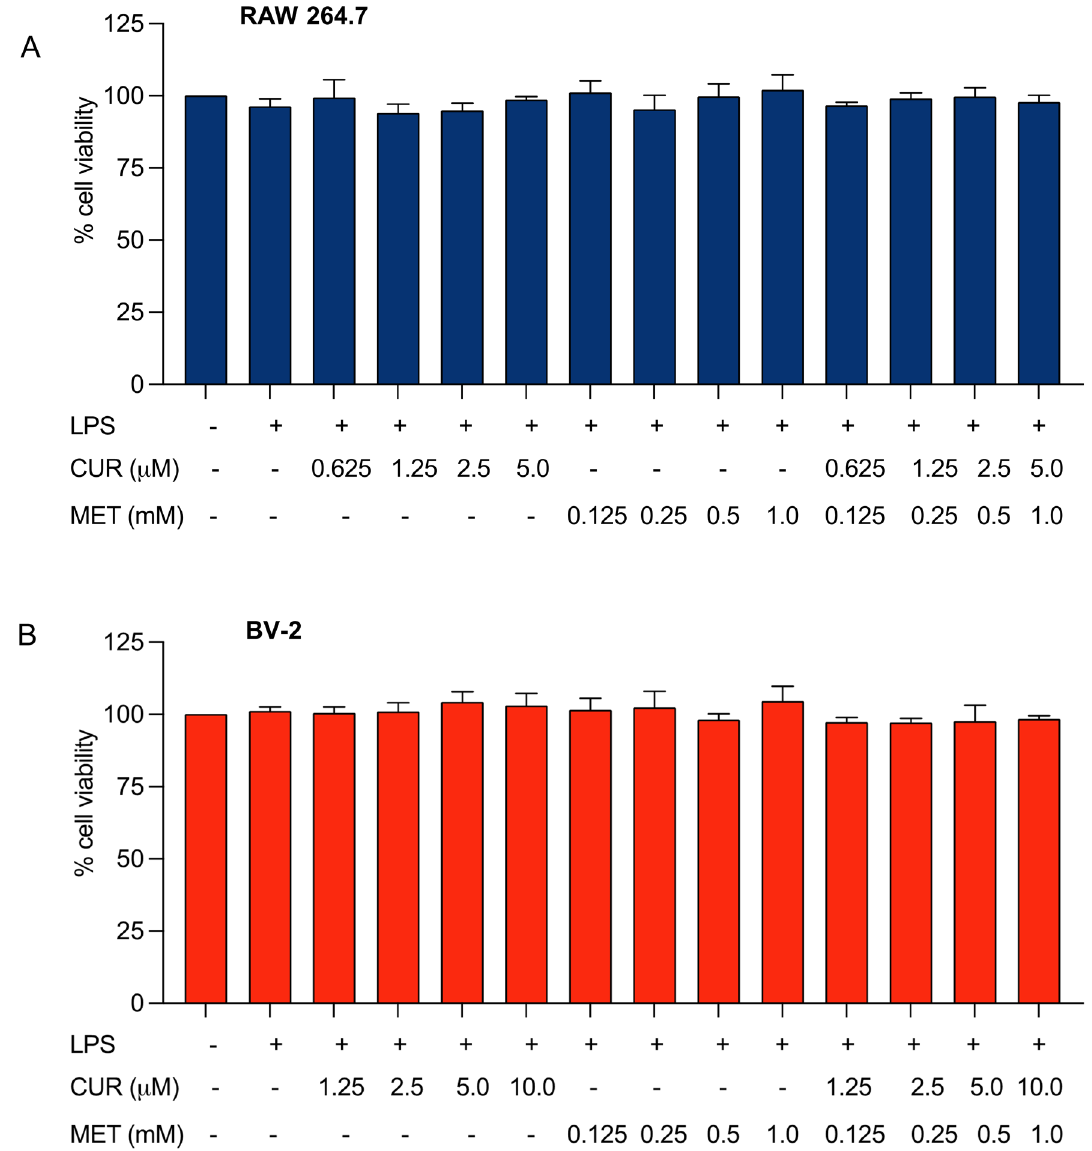
Figure 2. Cytotoxicity profile of LPS-stimulated RAW 264.7 macrophage ( A ) and BV-2 microglial ( B ) cells with or without treatment of curcumin (CUR), metformin (MET), or their combination. RAW 264.7 macrophages were treated with 0.625–5 µM of CUR, 0.125–1 mM of MET, or their combination at a 1:200 CUR: MET ratio for 12 h, whereas BV-2 cells were treated with 1.25–10 µM of CUR, 0.125–1 mM of MET or their combination at a 1:100 ratio of CUR: MET for 24 h. The cell viability was determined by MTT assay and expressed as a percentage of the control. Experimental data are presented as mean ± SD, n = 3 independent Initially, the maximum non-cytotoxic concentrations of each compound alone were determined, which were 5 µM and 10 µM for curcumin in RAW 264.7 and BV-2 cell lines, respectively, and 1 mM for metformin in both cell lines. Concentrations for combination treatment were determined based on their safety concentrations: cur- cumin and metformin ratios of 1:200 and 1:100 for RAW 264.7 and BV-2 cells, respectively. As shown in Fig. 2, none of the treatments at selected concentrations caused significant cytotoxicity on LPS-stimulated RAW 264.7 and BV-2 microglial cells: the cell viability was greater than 94%. Then the anti-inflammatory effect of curcumin and metformin in LPS-stimulated RAW 264.7 macrophage and BV-2 microglial cells was determined using the compounds alone and in combination. Treatment with LPS induces the release of nitric oxide, one of the main inflammatory mediators released at the inflammatory sites, into the culture medium. Secretion of nitric oxide (NO) is mediated via inducible nitric oxide synthase (iNOS), in which a high level of nitric oxide is identified as a marker of severe inflammation 36 . Therefore, the suppression of nitric oxide release is considered a plausible approach for the attenuation of the inflammatory process. The experiment was designed based on the Chou–Talalay method for synergy determination of drug combinations